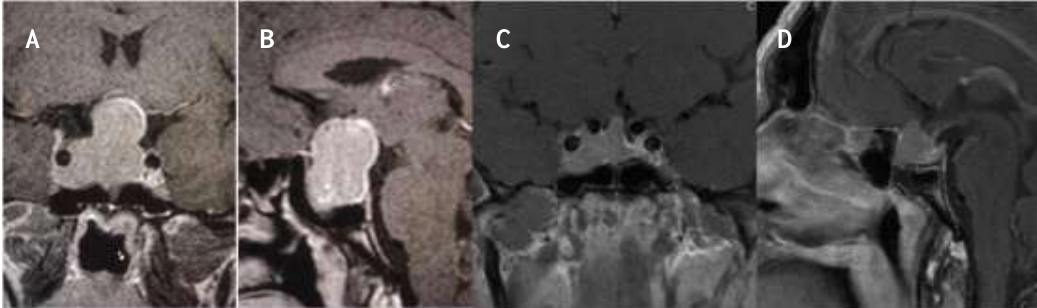
Figure 1. Magnetic resonance imaging showing macroadenoma (mass of 3.6 × 3.3 × 2.2 cm) in the sella turcica with right latero- and supra-sellar extension encasing the right internal carotid artery and compressing the optic chiasm: grade 4 according Knosp ( A : coronal, B : sagittal plane); more recent MRI showing a decrease in the size of the macrodenoma, still extending towards the floor of the third ventricle and encasing the right cavernous sinus in the coronal plane ( C ); in the sagittal plane, a rather lobulated suprasella extension is shown but no evidence of stalk involvement ( D ). Initial laboratory testing confirmed an elevated serum IGF-1 of 988 (94-284) ng / mL, no suppression of GH after a 75 g glucose load (7 ng / mL), mild hyperprolactinemia and hypogonadism.